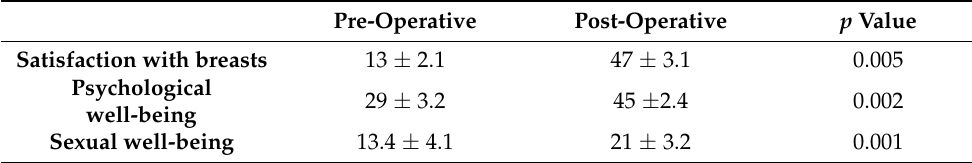
Table 3. Pre- and post-operative BREAST-Q values.